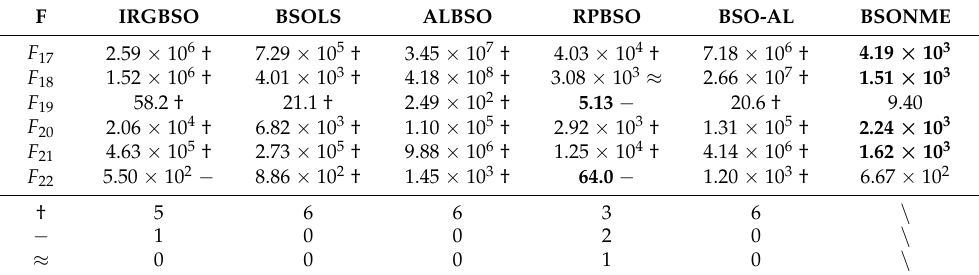
Table 10. Experimental results of IRGBSO, BSOLS, ALBSO, RPBSO, BSO-AL, and BSONME on F 17 – F 22